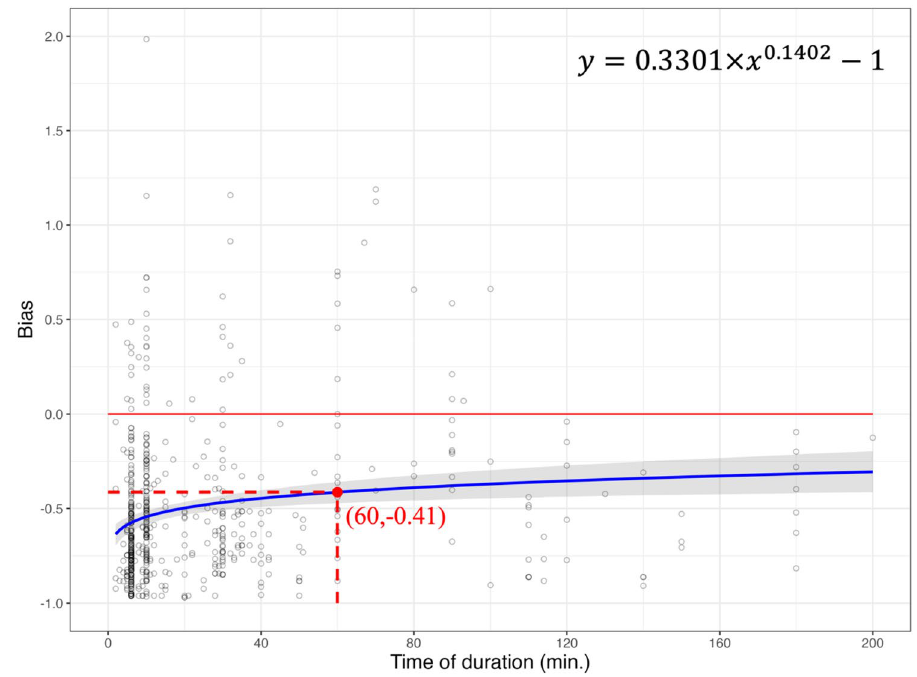
Figure 5. The relationship of duration on eBird checklists and bias. The power function (formula on the top right) estimated the non-linear relationship between duration and bias (blue solid line). Bias was derived from the results of estimated species richness in eBird and average estimated species richness from BBS (black circle). Where bias = 0 (red solid horizontal line) indicates no differences among estimated species richness from eBird and average estimated species richness from BBS, indicating eBird could record an average of 100% of the BBS species